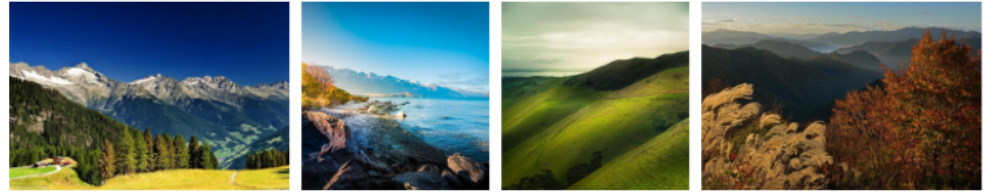
Figure 28. Sample Training Images for